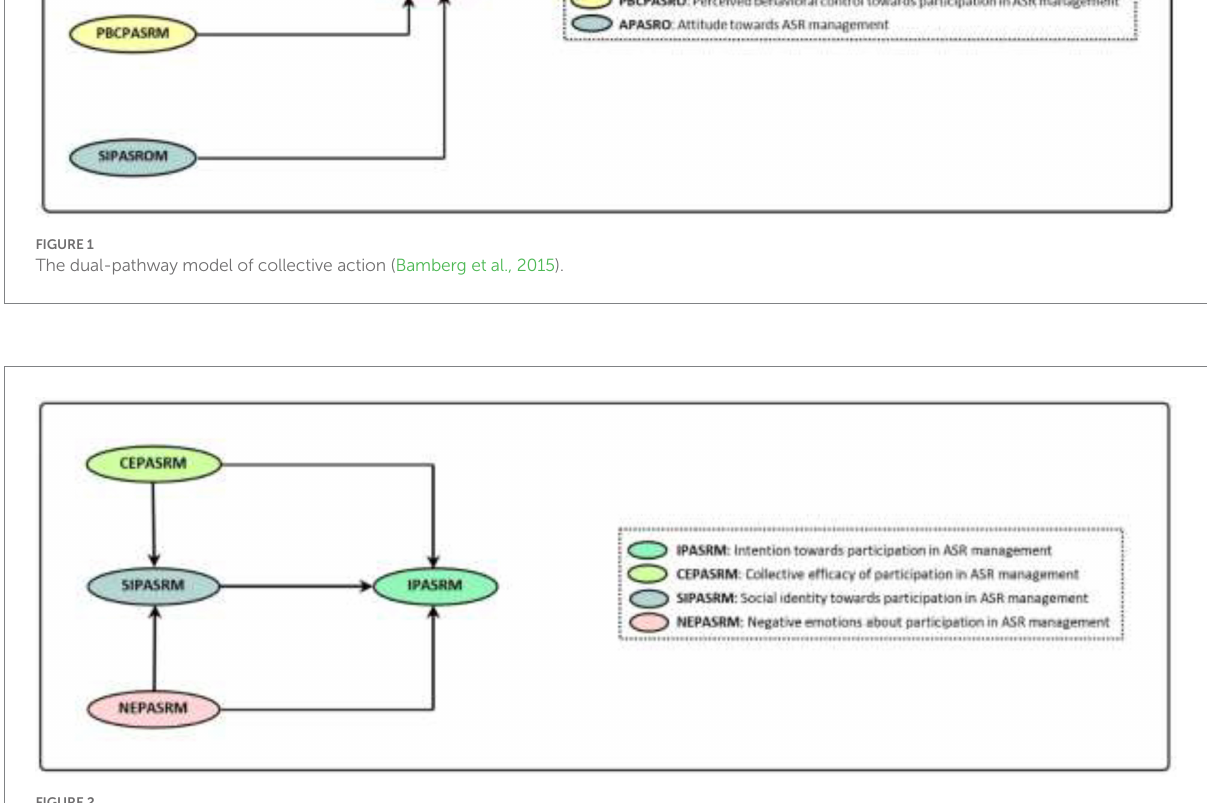
FIGURE 2 The relationships of variables in EMSICA (Thomas et al., 2009,